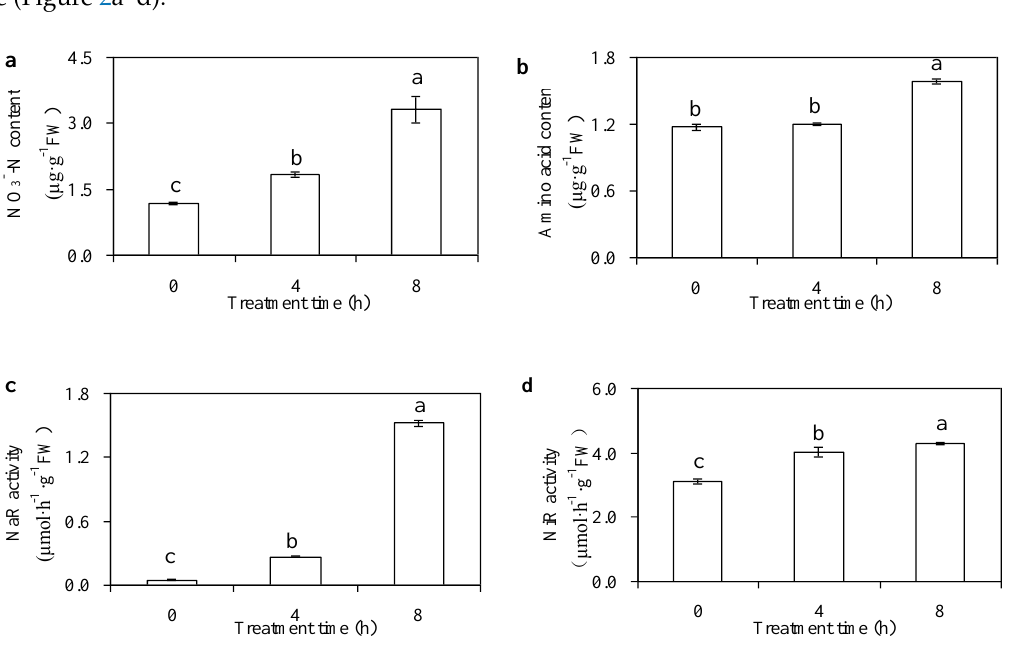
Figure 2. Effects of N Metabolism Indicators. ( a ) NO 3 − -N content, ( b ) amino acid content, ( c ) nitrate reductase activity, and ( d ) nitrite reductase activity in leaves of mulberry seedlings exposure to 4 µ L · L − 1 NO 2 for 0 h, 4 h (4 h · d − 1 , for one day), and 8 h (4 h · d − 1 , for 2 days). Date represent means of four plants ± standard deviations. Different lowercase letters for the same parameter indicate significant differences among different treatments at p < 0.05 levels.